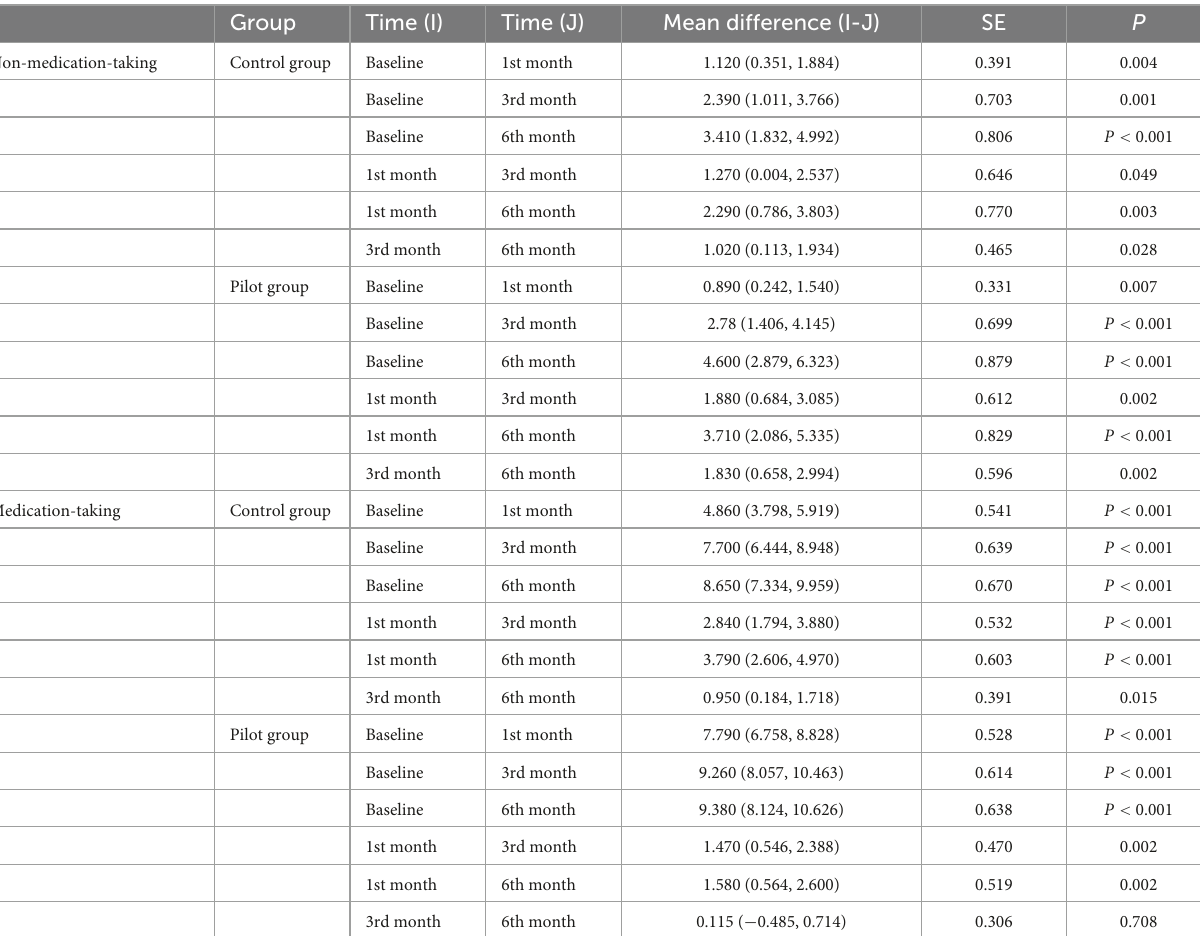
TABLE 4 Simple effect analysis of time